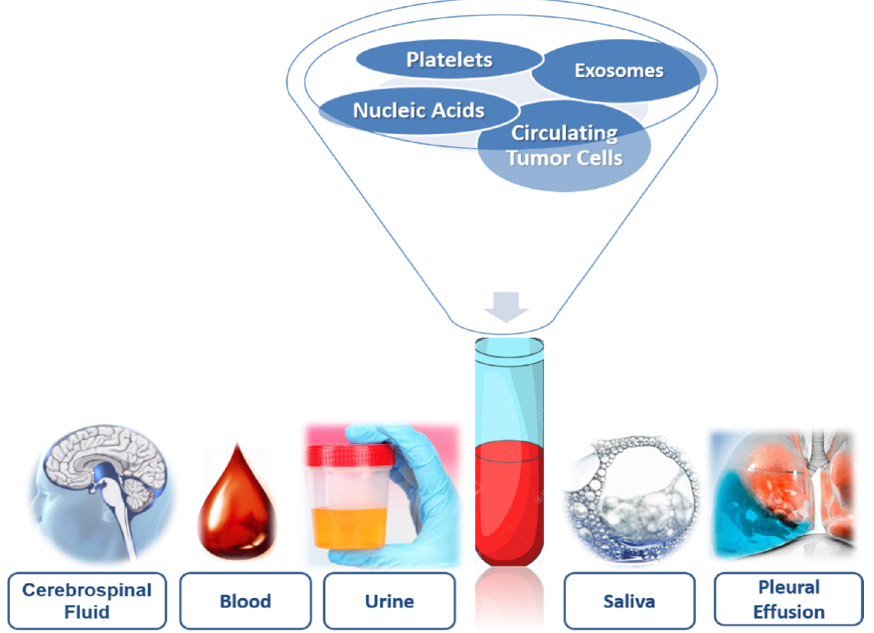
Figure 1. Components of liquid biopsy.